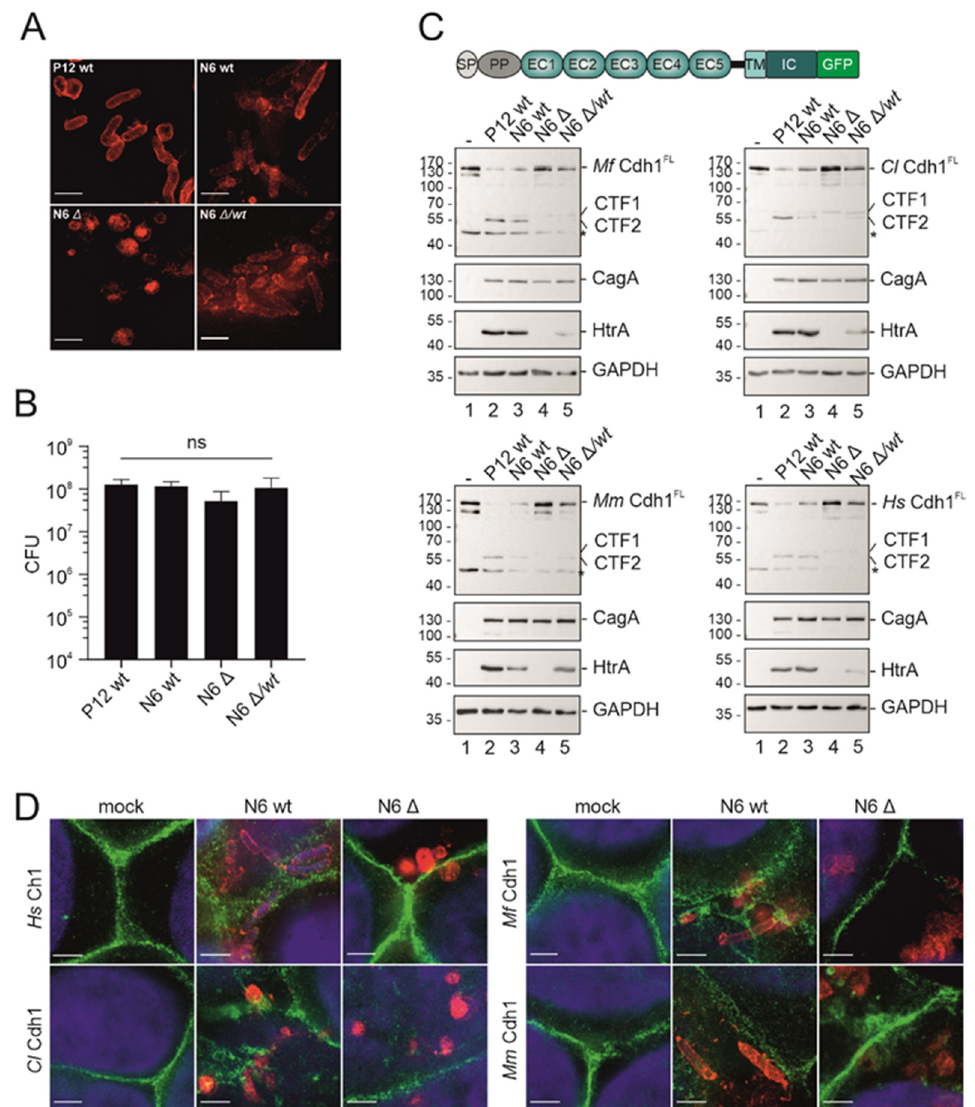
Figure 4. Infection of gastric epithelial cells expressing Cdh1 orthologues . ( A ) Representative STED images of H. pylori P12 wt, N6 wt, N6 Δ htrA, and N6 Δ htrA/htrA wt bacteria attached to gastric epithelial cells stained using a polyclonal serum raised against H. pylori lysate. Scale bar, 2 µm. ( B ) MKN-28 wt cells were infected with H. pylori P12 wt, N6 wt, N6 Δ htrA, and N6 Δ htrA/htrA wt for 6 h and the number of bacterial cells adhering to MKN-28 cells was quantified and are presented as mean values ± SD ( n = 4). CFU, colony forming unit; ns, not significant. ( C ) MKN-28 cells stably expressing Cdh1 proteins as indicated were infected with H. pylori P12 wt, N6 wt, N6 Δ htrA, and N6 Δ htrA/htrA wt for 24 h. Non-infected cells served as control. Whole cell lysates of infected cells were analyzed by Western blotting for Cdh1 full length (Cdh1 FL ) and the C-terminal fragments CFT1 and CTF2 using an antibody recognizing the intracellular domain of Cdh1 (first panel). CagA and HtrA were detected as loading controls for H. pylori (second and third panel). Loading control for MKN-28 cells was performed by detection of GAPDH (fourth panel). *, unspecific band. ( D ) Representative STED images of MKN-28 cells stably expressing Cdh1 proteins (green) derived from Hs , Mf , Cl , and Mm infected with H. pylori N6 wt and N6 ∆ htrA bacteria (red), or uninfected controls (mock); Nuclei were stained using DAPI (blue). Scale bars, 2 µ